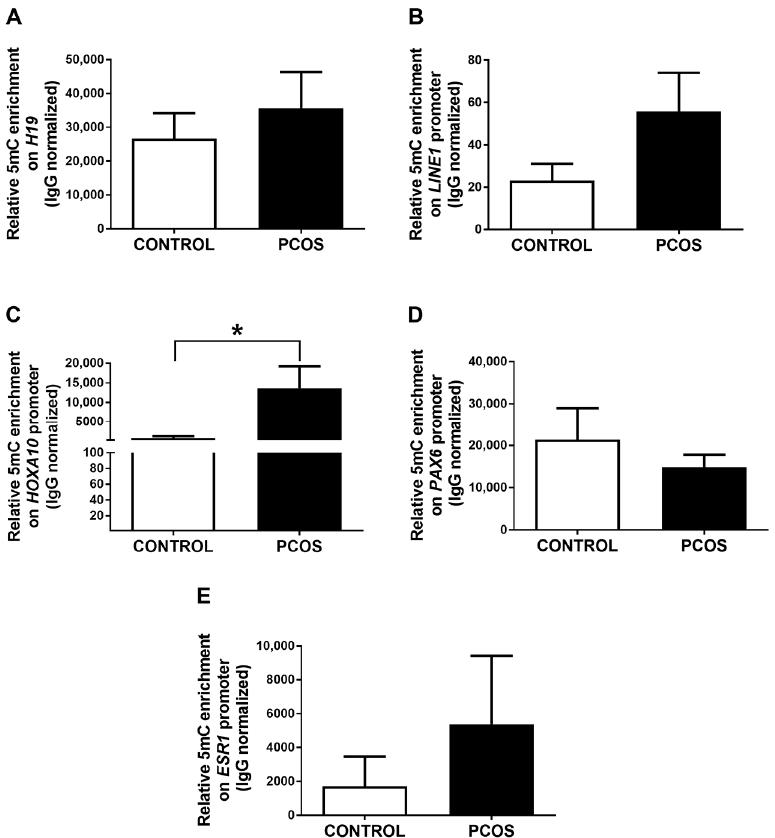
Figure 2. Content of DNA methylation at global markers and promoters of genes related to endometrium function in PCOS patients and controls. The relative levels of 5-methylcytosine (5mC) enrichment on H19 gene ( A ), LINE-1 ( B ), and promoters of genes HOXA10 ( C ), PAX6 ( D ), and ESR1 ( E ) are shown for healthy women (CONTROL) and PCOS patients without treatment (PCOS). Data were obtained using MeDIP-qPCR and analyzed with the ∆∆ Ct method, normalizing with IgG enrichment. Results are expressed as mean ± SE. * p ≤ 0.05 vs.